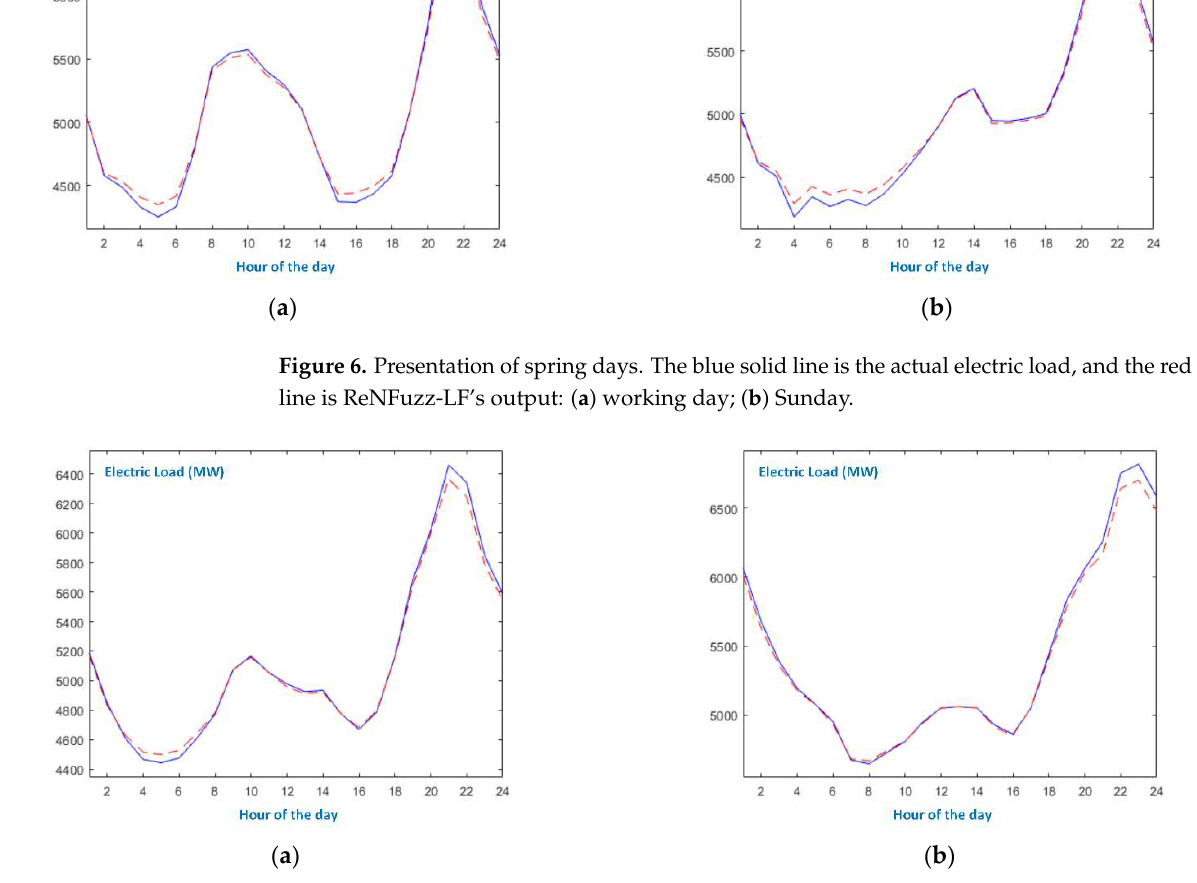
dotted line is ReNFuzz-LF’s output: ( a ) working day; ( b ) Sunday.